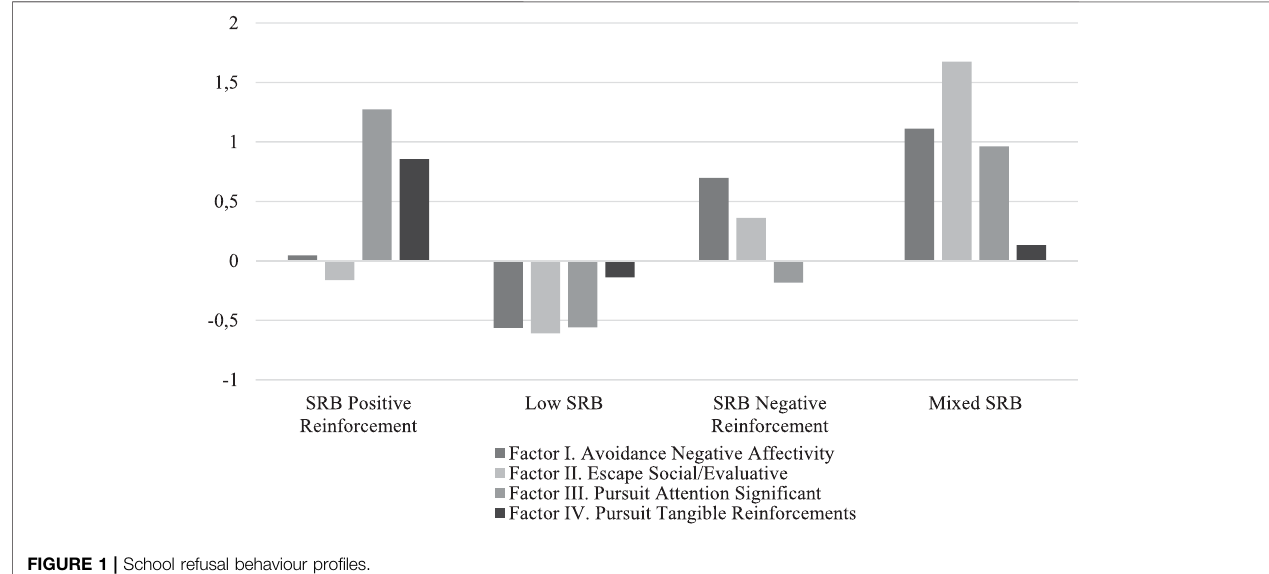
FIGURE 1 | School refusal behaviour pro fi les.